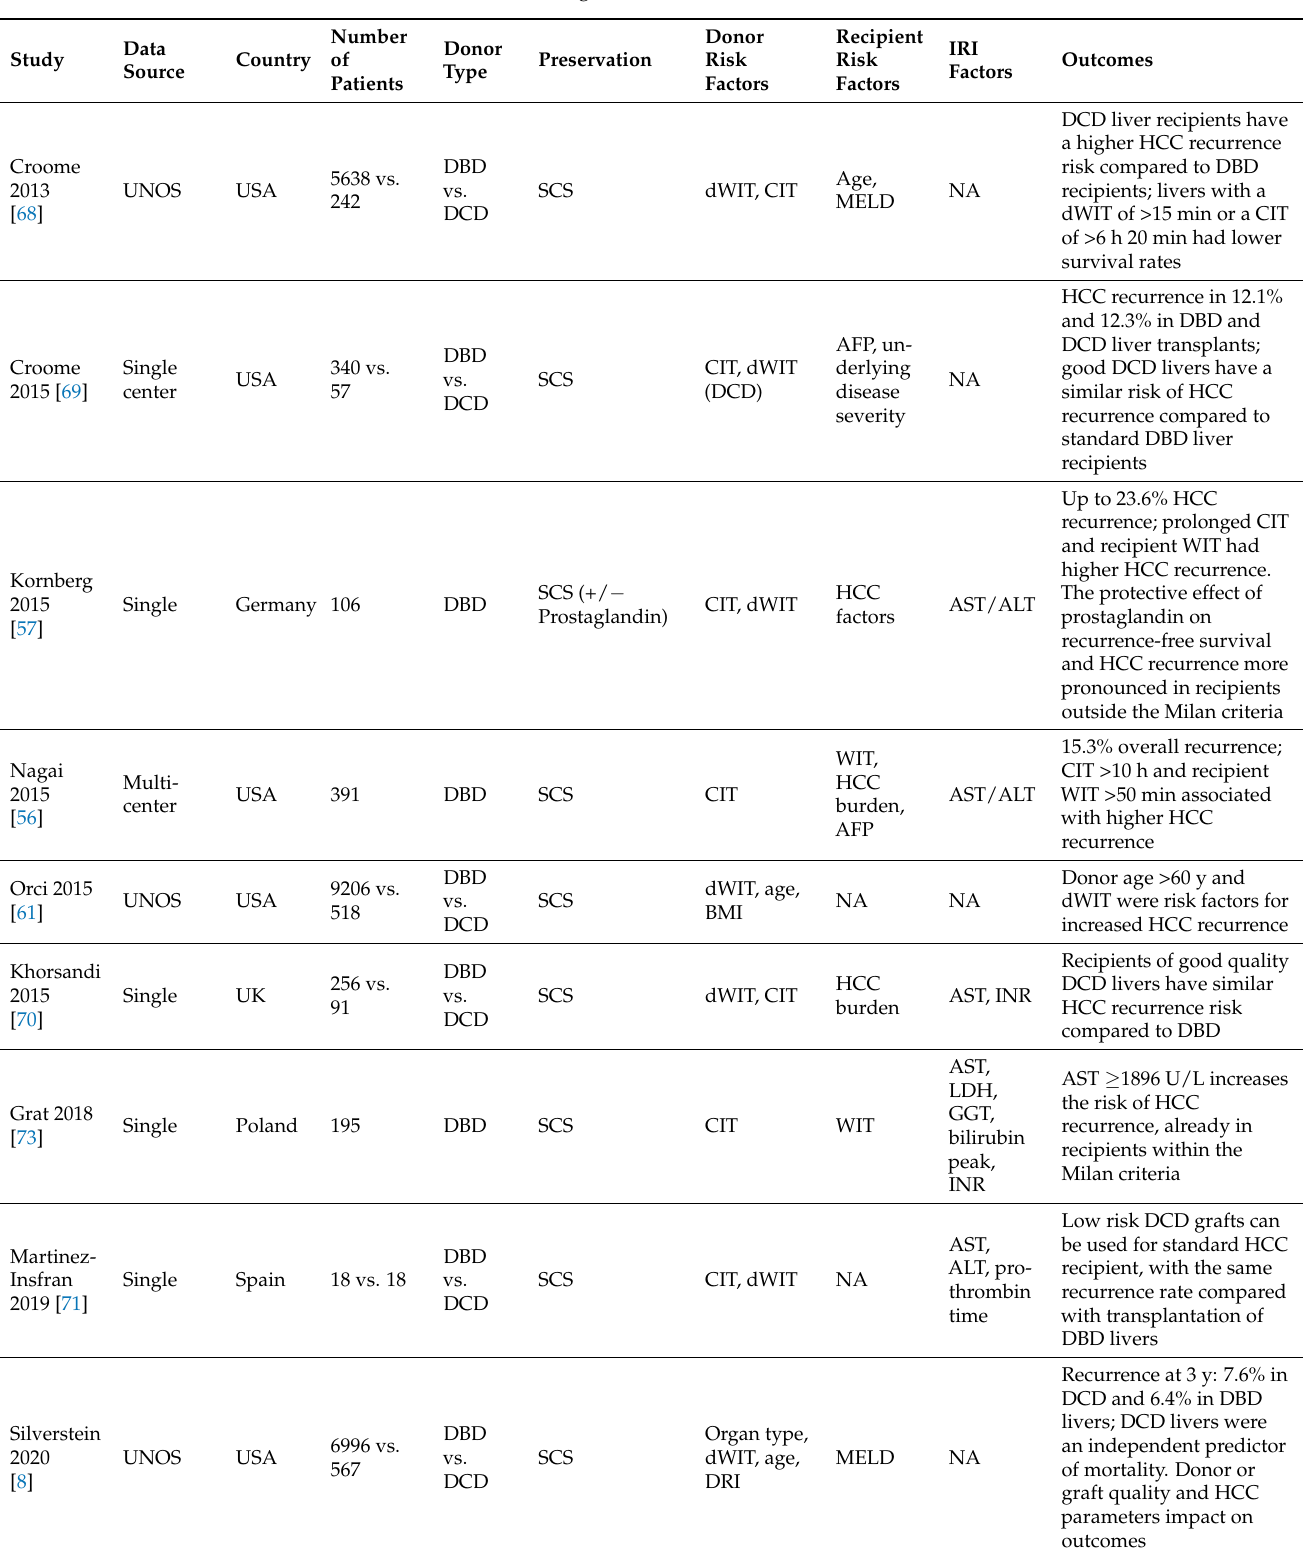
Table 1. Studies evaluating risk factors for IRI associated with HCC